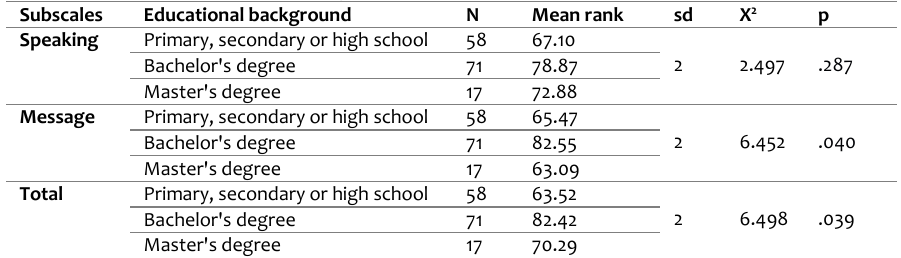
Table 5. The Parent-Child Communication Assessment Tool (PCCAT) Kruskal Wallis Test Results regarding the Subscale Scores for the Educational Background of the Father